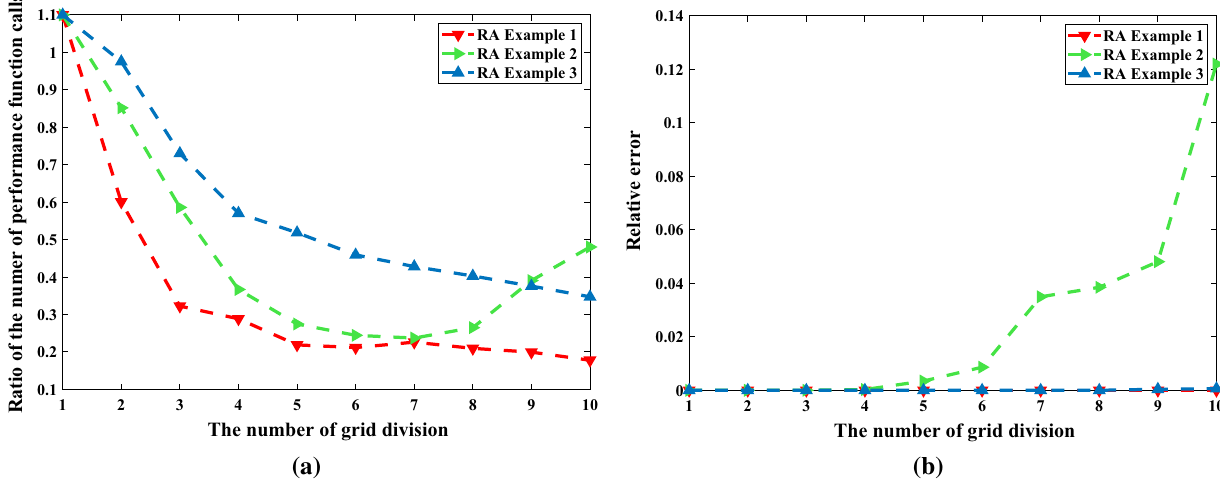
Fig. 7 Grid division analysis of the GFWSM on the three reliability analysis examples: a the ratio of the N pfe of GFWSM to that of WSM ( r gw ), b the relative error of GFWSM to WSM ( e gw